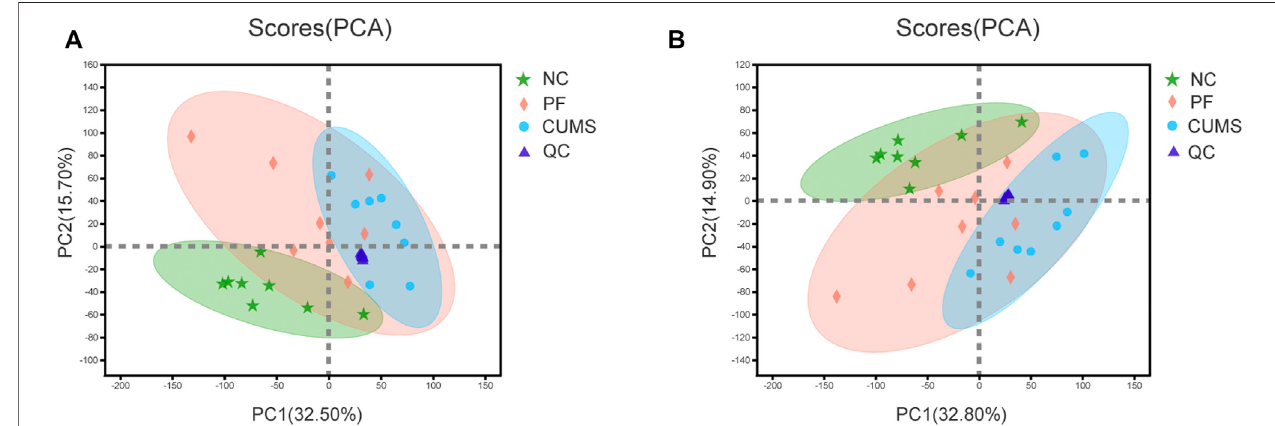
FIGURE 2 | PCA score plot. Plot of PCA scores for the NC ( ), CUMS ( ) PF ( ) and QC ( ) groups based on data acquired in positive and negative ion modes (A,B) .